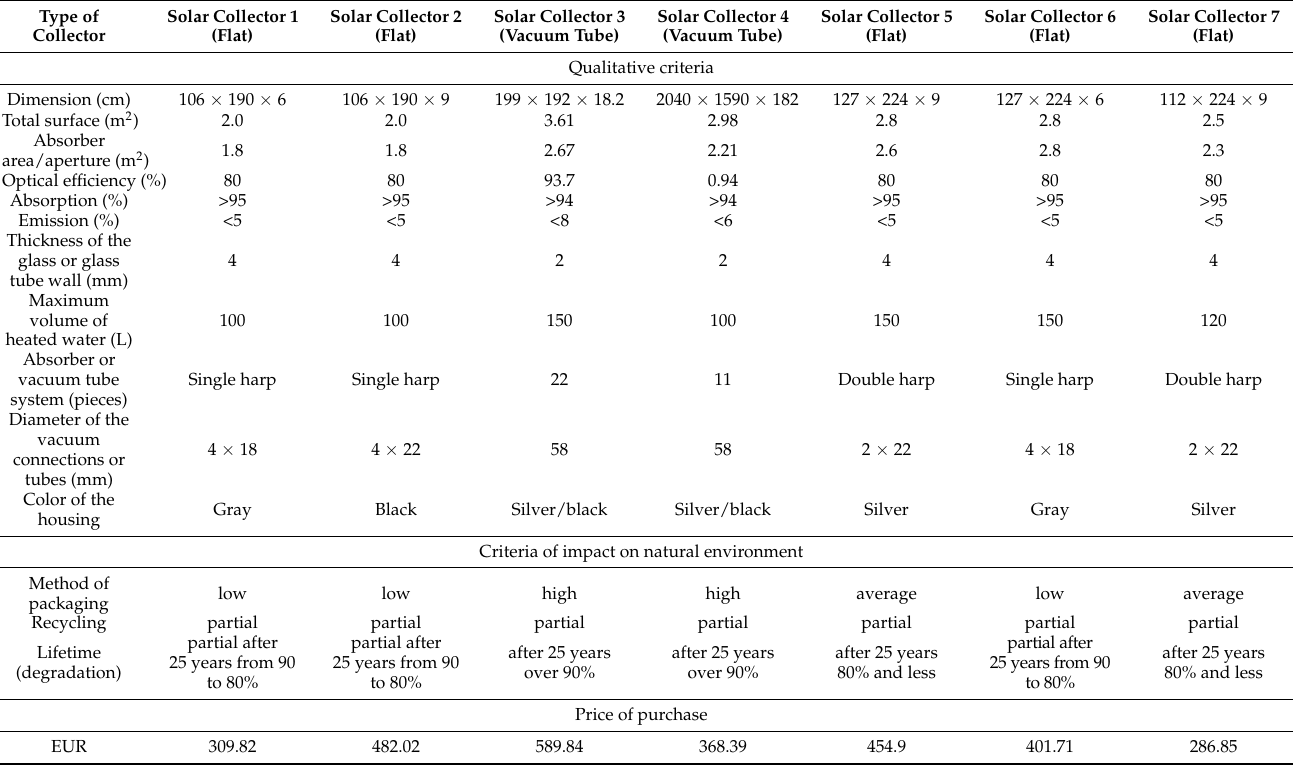
Table 1. Characteristics of solar collectors selected for analysis.